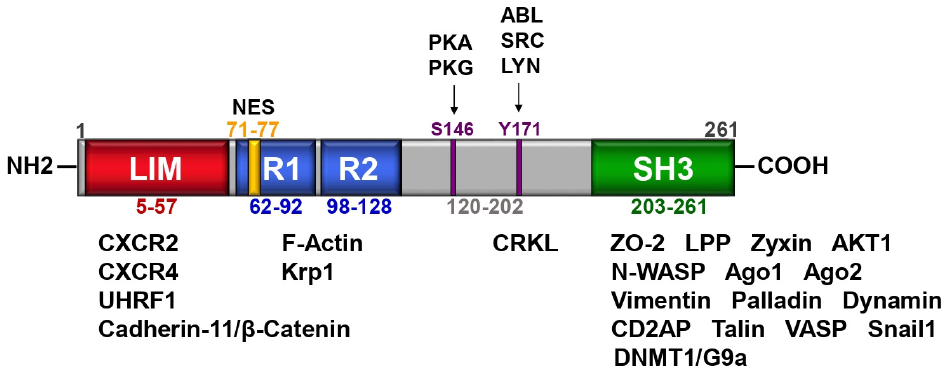
Figure 1. Graphic illustration of LASP1 domain structure. LASP1 consists of a LIM (LIN-11, Isl-1, and MEC-3) domain (red), two F-actin binding nebulin repeats (R1 and R2) (blue), a linker site with two key regulatory phosphorylation sites (S146 and Y171) (purple), and a SH3 (Src Homology 3) domain (green). The first nebulin repeat includes a nuclear export signal (NES) between residues 71-77 (yellow). Known domain-specific protein–protein interactions are provided.